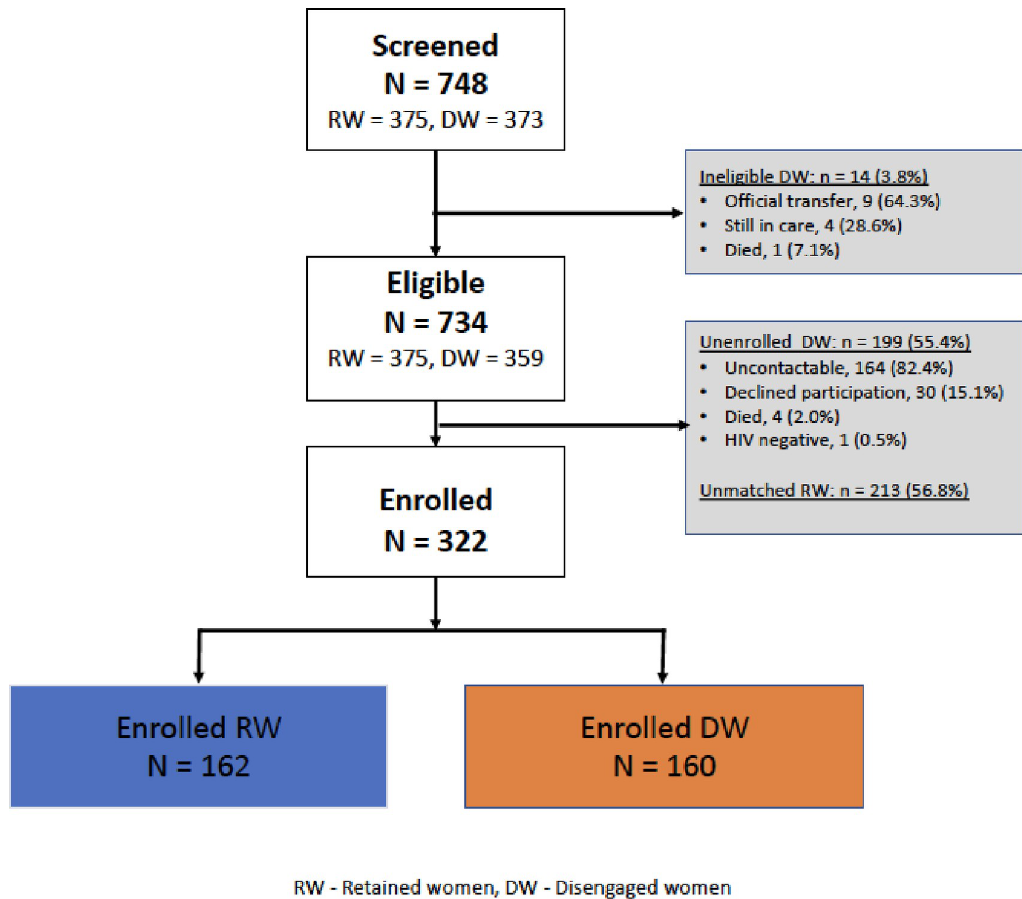
Fig 1. Study cohort diagram showing HIV positive retained and disengaged women enrolled in a community outreach study between July 2017 –July 2018 from six Kampala City Council public municipal clinics in